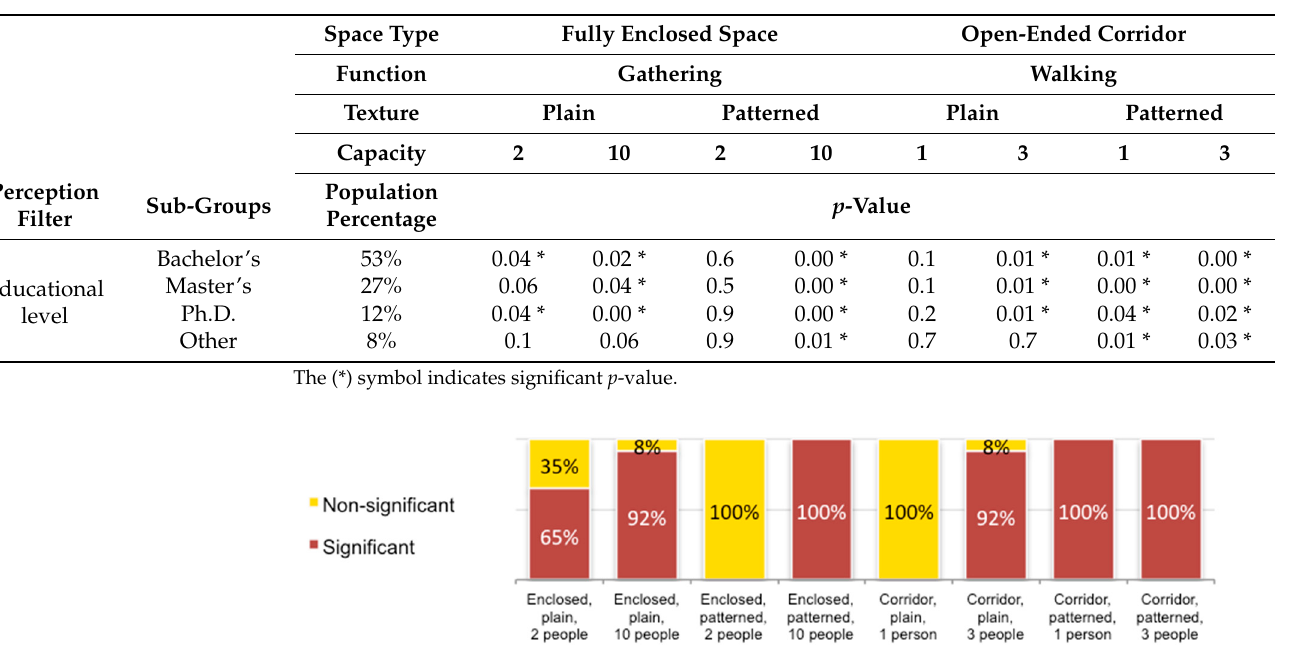
Table 4. Educational level perception filter and comparisons of space size variations between IVRIE and DT systems.